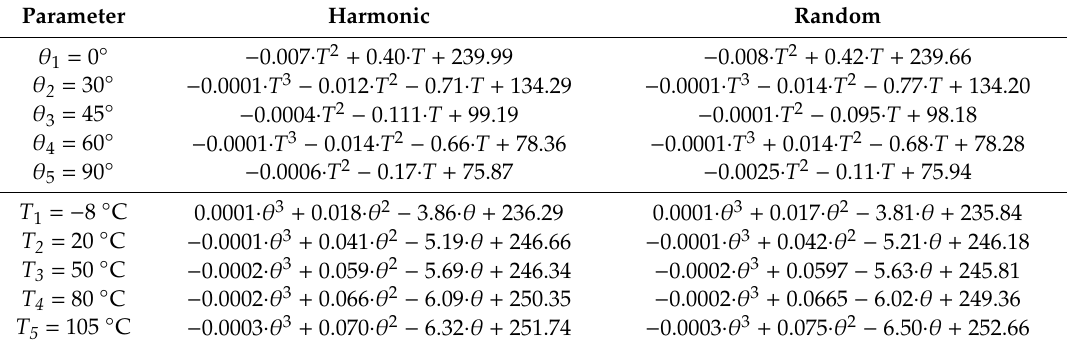
Table 6. Curve-fitted polynomial function of the first resonance frequency ( ω n ,1 ) with respect to the parameters of